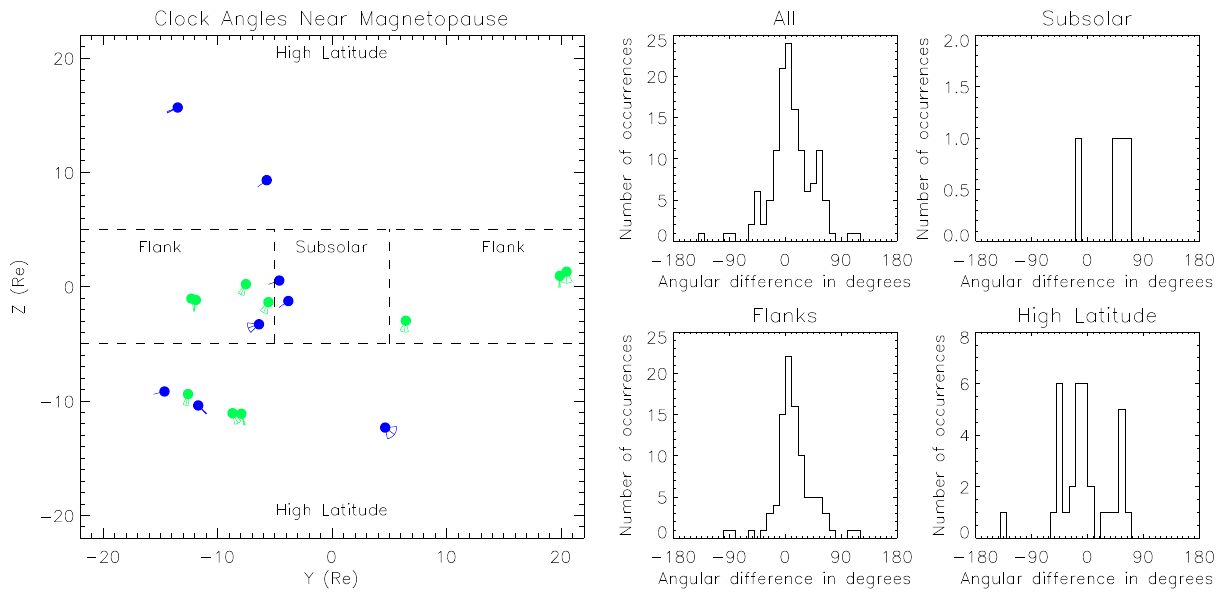
Fig. 11. Clock angles measured near magnetopause, and angular differences from perfect draping, for high solar wind dynamic pressure and Southward IMF. Format as Fig. 2.